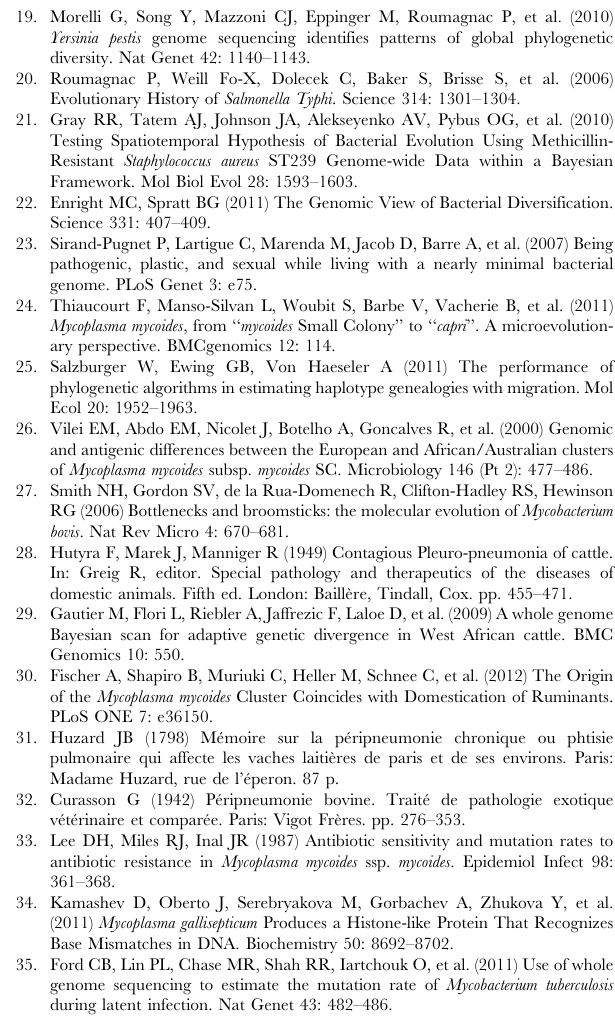
Table S1 List of MmmSC concatenated genes. Table S2 List of Mycoplasma mycoides subsp. my- coides ‘‘Small Colony’’ strains studied.